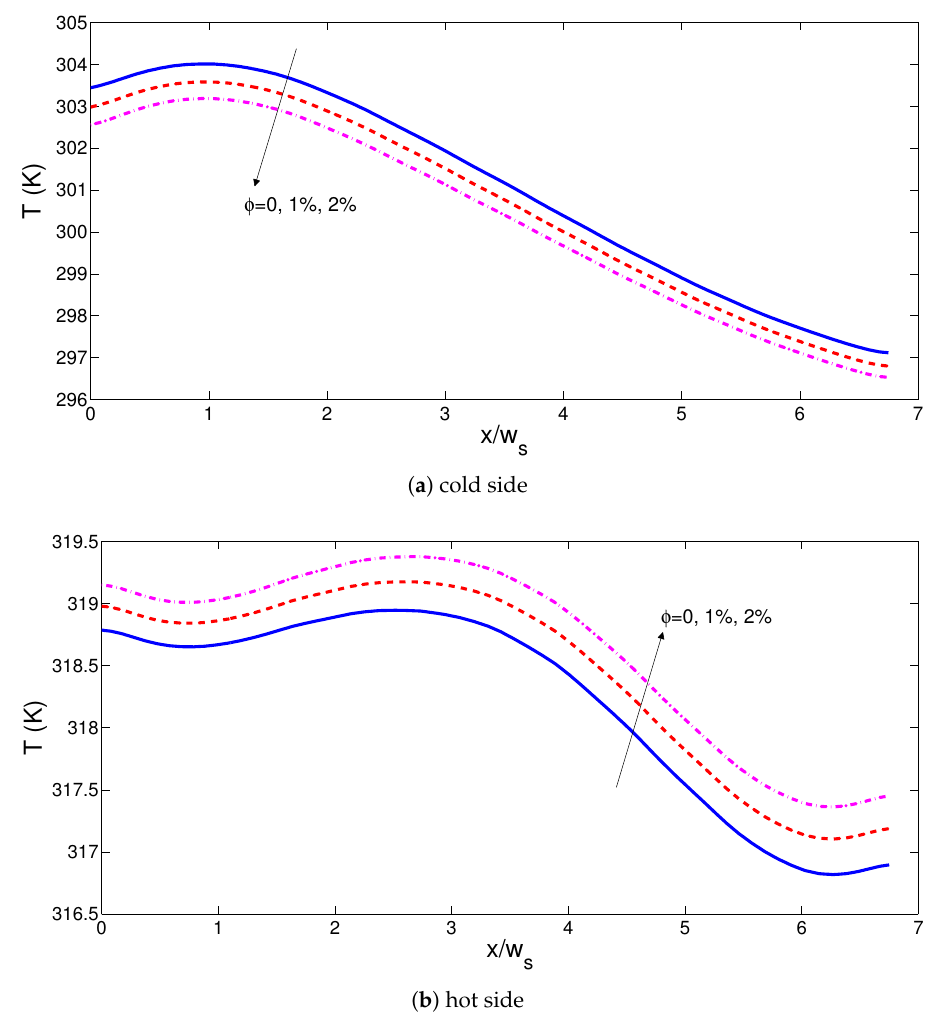
Figure 14. Impacts of solid nanoparticle volume fractions of CNT on the variation of cold and hot interface temperatures ((Re 1 , Re 2 ) = (500, 500), (r 1 , r 2 ) = (1, 1), z h = 3w s ).